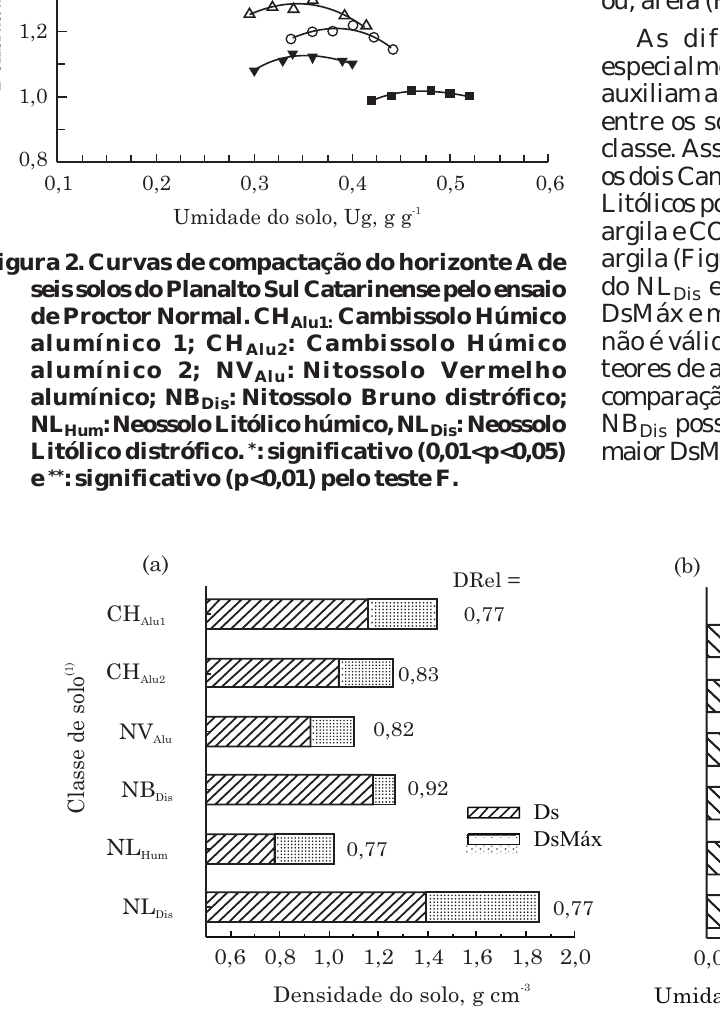
Figura 3. Densidade do solo (Ds), densidade máxima (DsMáx), densidade relativa (DRel) (a) e umidade ótima de compactação (UOC) (b) do horizonte A de seis solos do Planalto Sul Catarinense. (1) CH Alu1 : Cambissolo Húmico alumínico 1; CH Alu2 : Cambissolo Húmico alumínico 2; NV Alu : Nitossolo Vermelho alumínico; NB Dis : Nitossolo Bruno distrófico; NL Hum : Neossolo Litólico húmico, NL Dis : Neossolo Litólico distrófico.